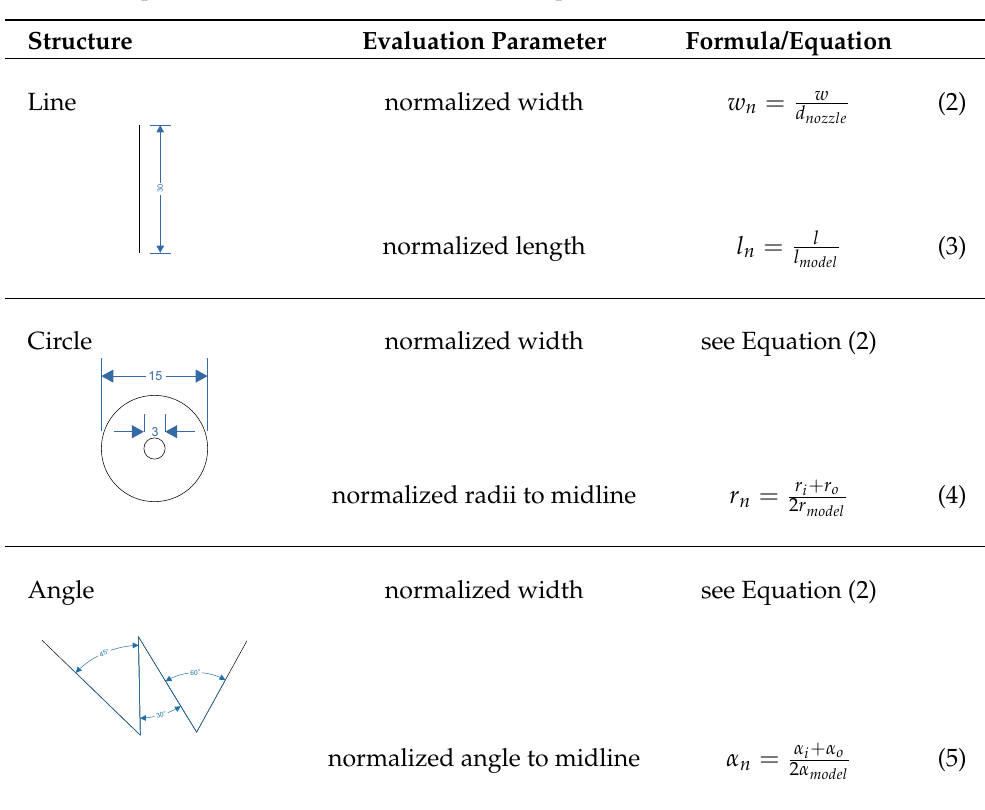
Table 2. Graphic models of the printing path. Images of the printed objects are taken and analyzed as a part of the printing accuracy assessment. The dimensions in the line and circle sketches are given in millimeter (mm), the dimensions in the angle sketch in degrees ( ◦ ). Each structure was examined for characteristic parameters, which are shown with the respective formulae for